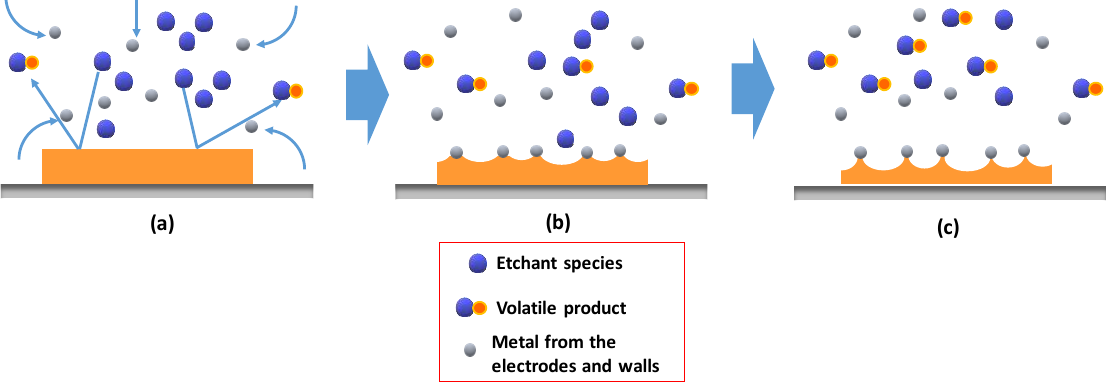
Figure 10. Schematized mechanism of the plasma nano-texturing of polymers. ( a ) plasma ignition, etchant species producing volatile species; ( b ) during plasma etching metal clusters stick on the sample, masking the surface; ( c ) Etching proceed though the nanomask.